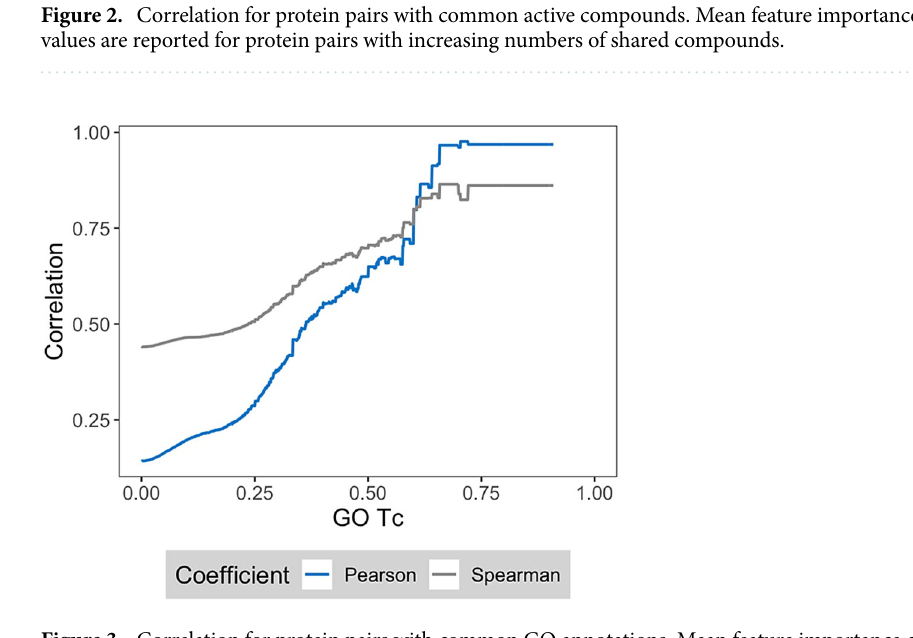
Figure 3. Correlation for protein pairs with common GO annotations. Mean feature importance correlation values are reported for protein pairs with increasing GO Tc